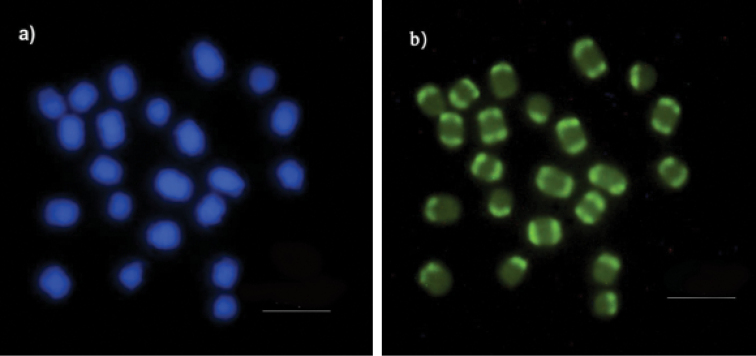
Fluorochrome staining of Melipona
seminigra
merrillae chromosomes aDAPI, with uniform staining on almost every chromosome b CMA3, showing euchromatin in terminal regions of all chromosomes. Scale bars: 10 μm.